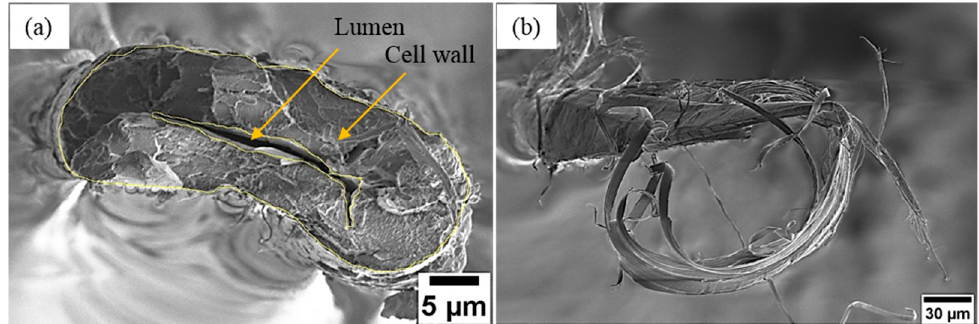
Figure 2. LV-SEM images of the fractured surface of single ramie fibers under tensile load ( a ) example of flat cross-section end and ( b ) example of single fiber split into fibrils. More SEM images are shown in the supplementary materials (Figures S3 and S4).